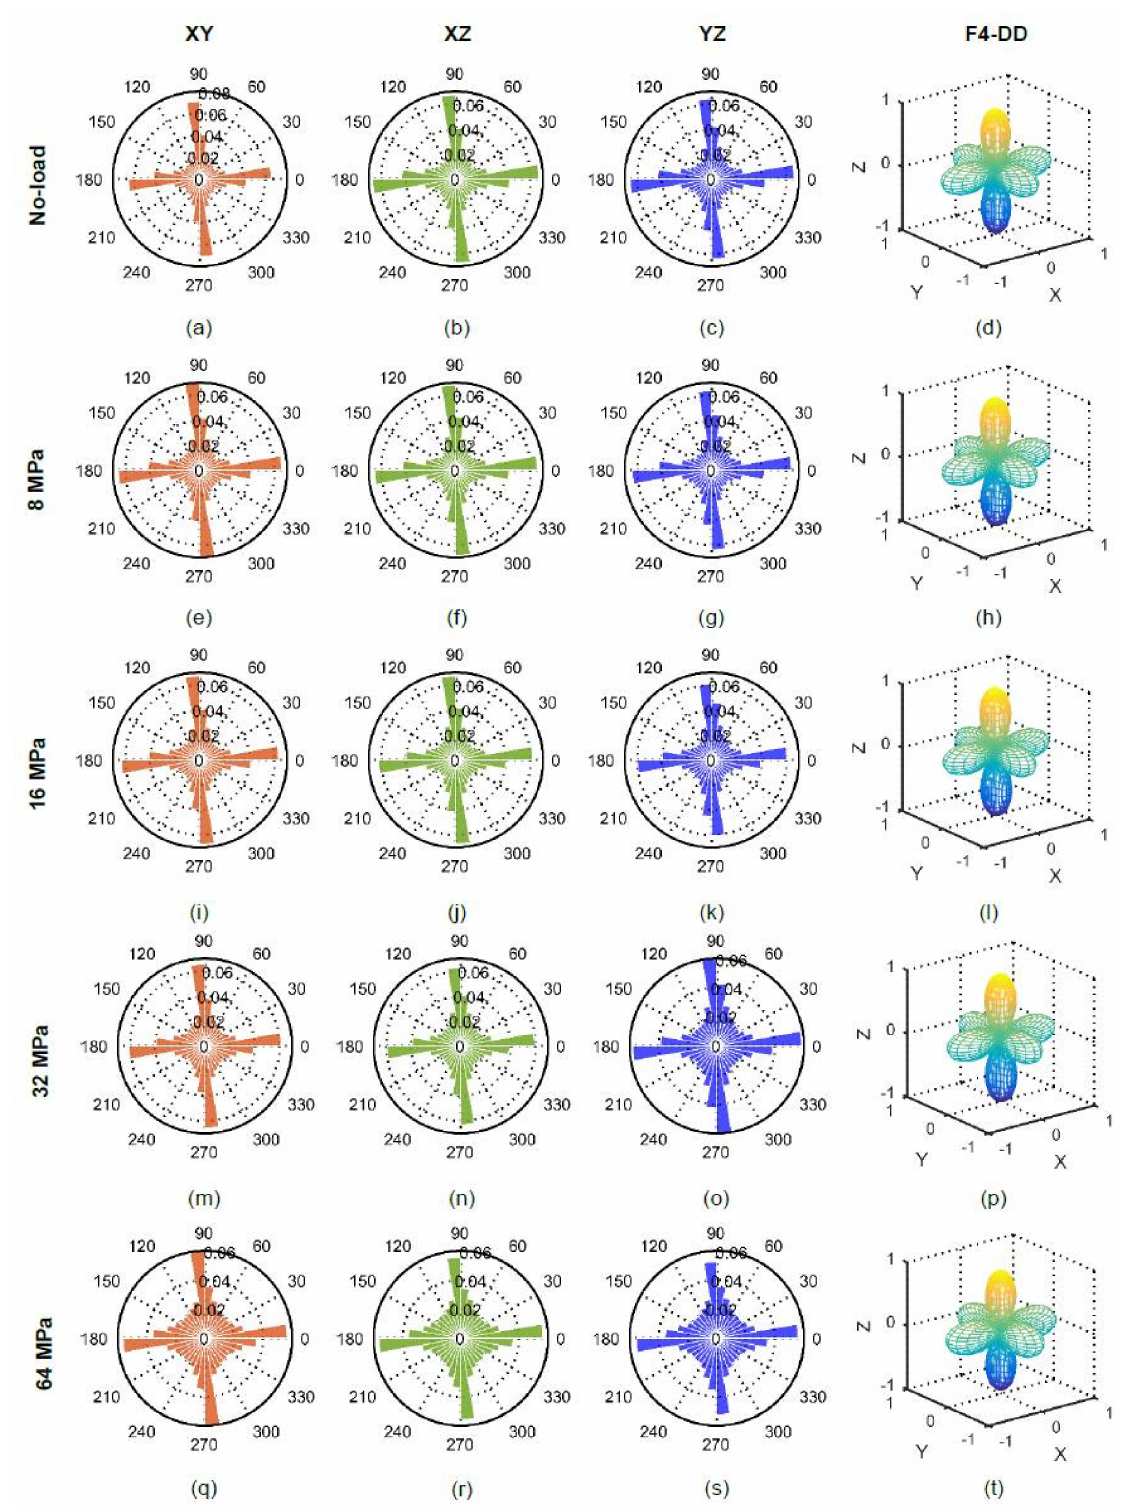
Figure 20. Contact normal vectors of RBS particles at different vertical stresses (F4-DD: 4th order approximation of distribution